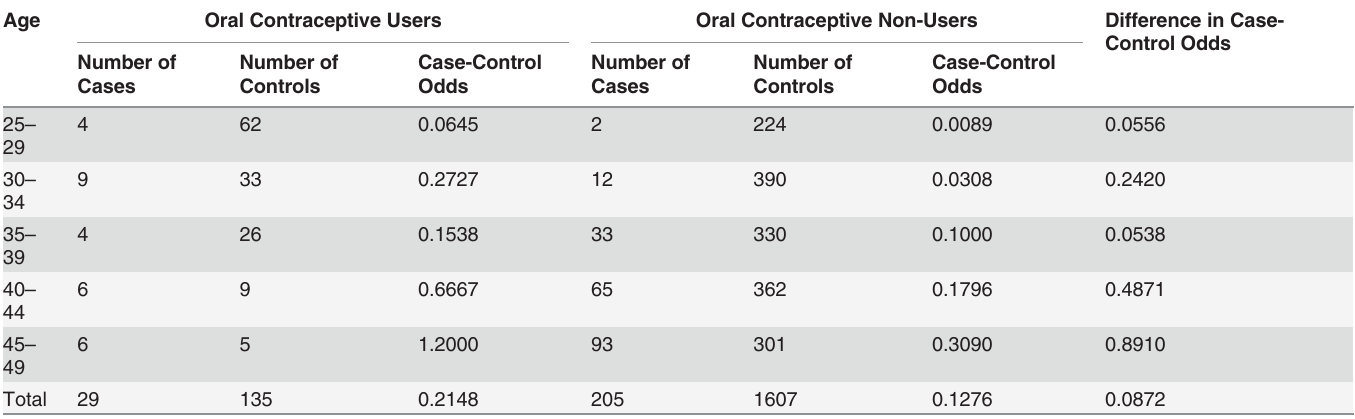
Table 1. Age-specific relation of myocardial infarction to recent oral contraceptive use.